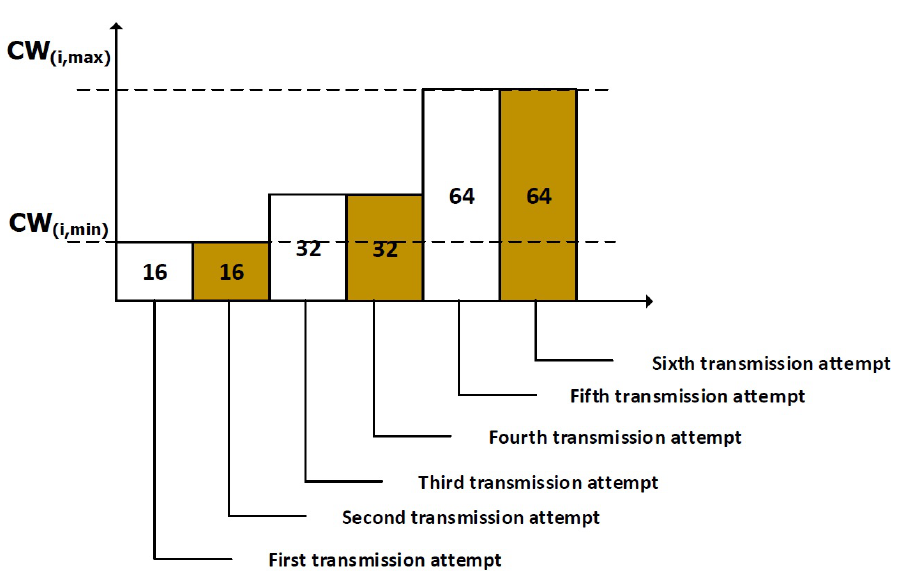
Figure 3. Backoff process in IEEE